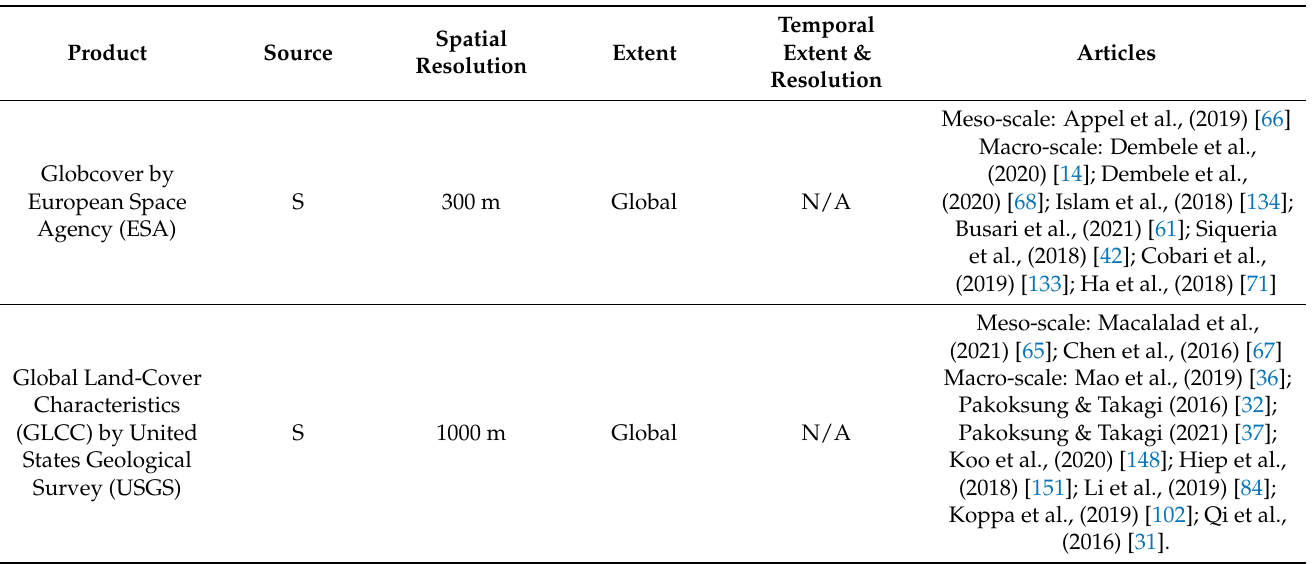
Table A3. Land-Use/Land-Change (LULC) datasets used in reviewed